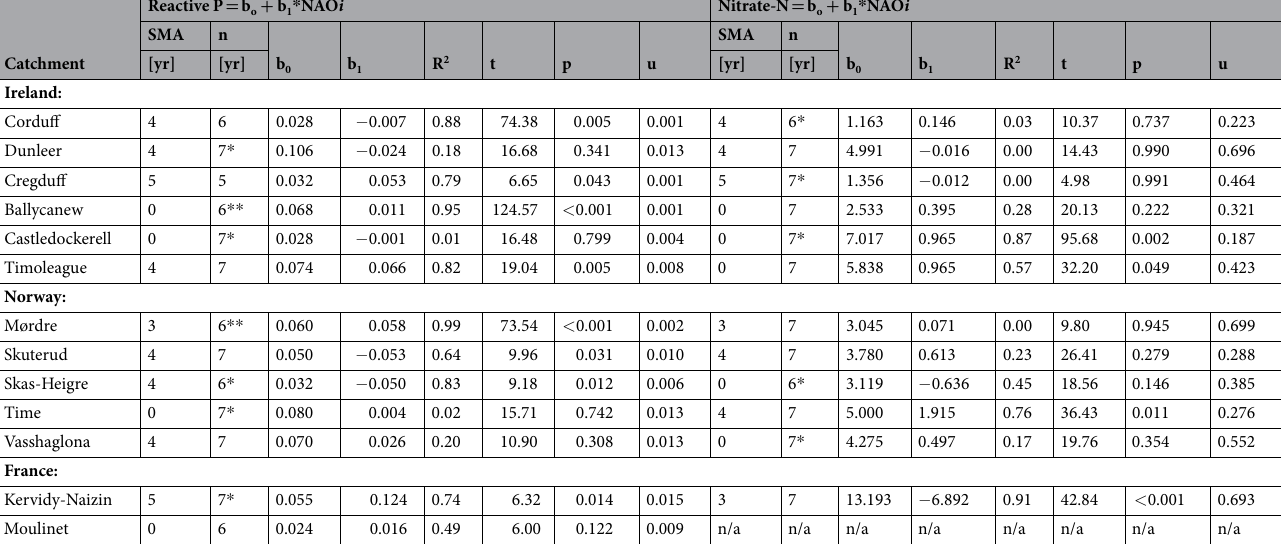
Table 2. Linear regression analysis of Reactive P and Nitrate-N concentrations in rivers to NAO i . * Analysis includes an outlier year as defined by Cook’s D test > 1. ** Analysis excludes an outlier year as defined by Cook’s D test > 1. Antecedent simple moving averages (SMA) used for best correlation, number of analysed years